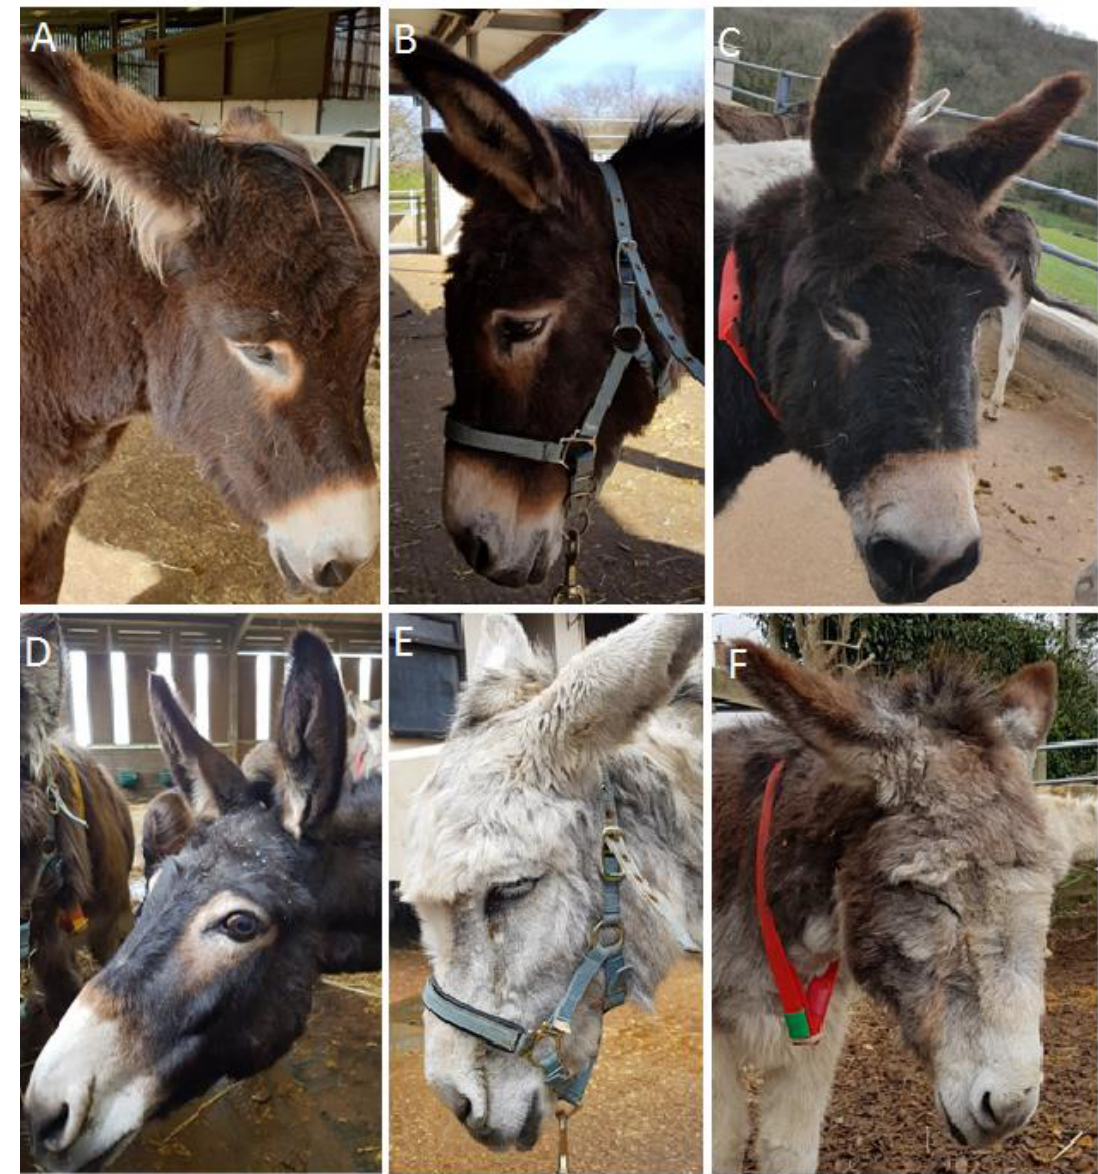
Figure 1. Examples of facial characteristics of donkeys with acute pain: backwards-directed ears ( A ), more open eyelids ( B ), obviously opened nostrils ( C ), obviously more opened eyes with sclera visible ( D ), obviously lifted corners of the mouth ( E ), obvious orbital tightening of eyelids ( F ).